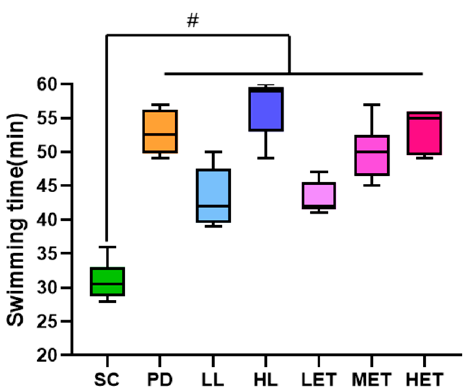
Figure 4. Effects of LBP and LBPT on exhaustive swimming time of rats. Data are expressed as mean ±SD, N = 8. #: vs. SC, p < 0.05.